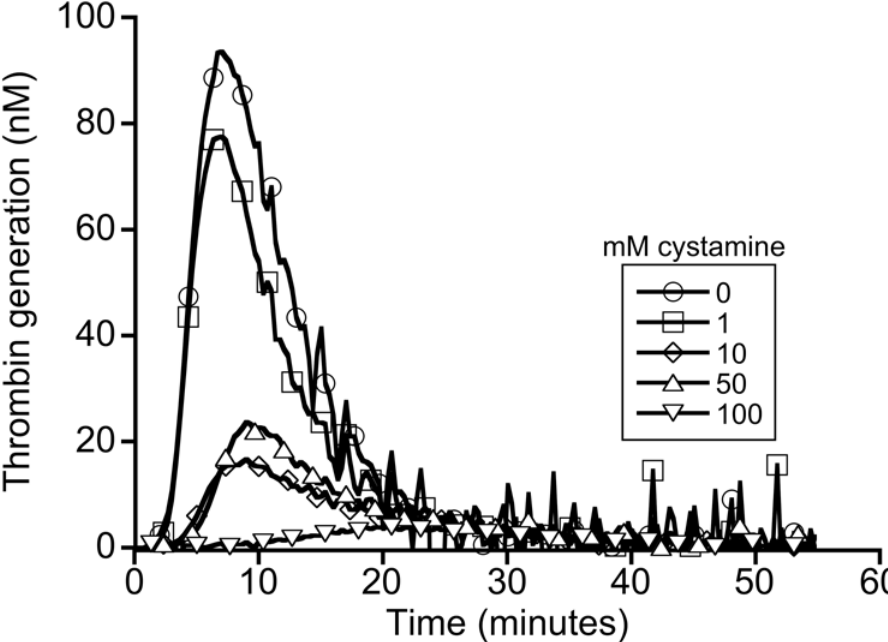
Fig 3. Cystamine inhibits thrombin generation. Plasma thrombin generation was triggered by re- calcification and addition of tissue factor and phospholipids, in the presence of cystamine. Thrombin generation was monitored by calibrated automated thrombography. The data are representative of four